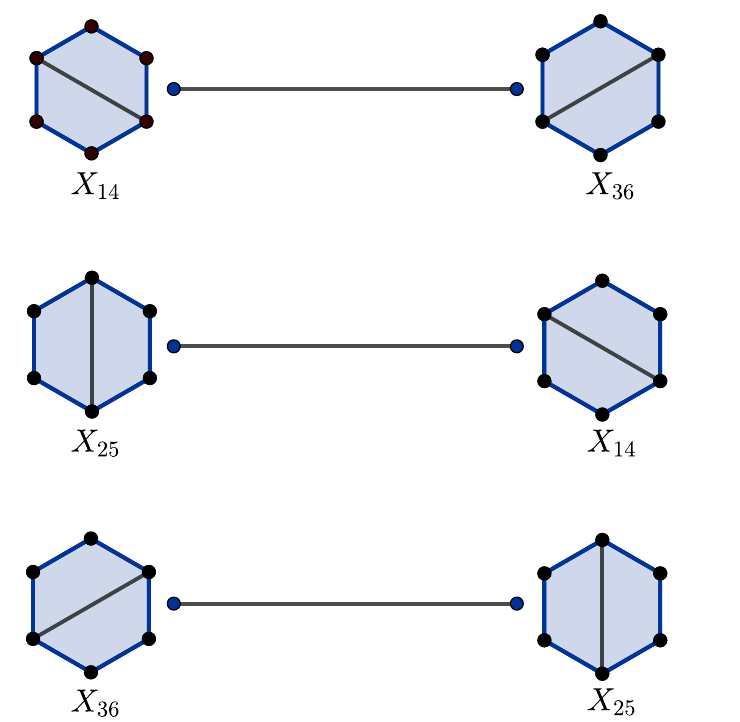
Figure 2 . Accordiohedra for 6 -particle scattering in φ 4 . Reference dissections are on the